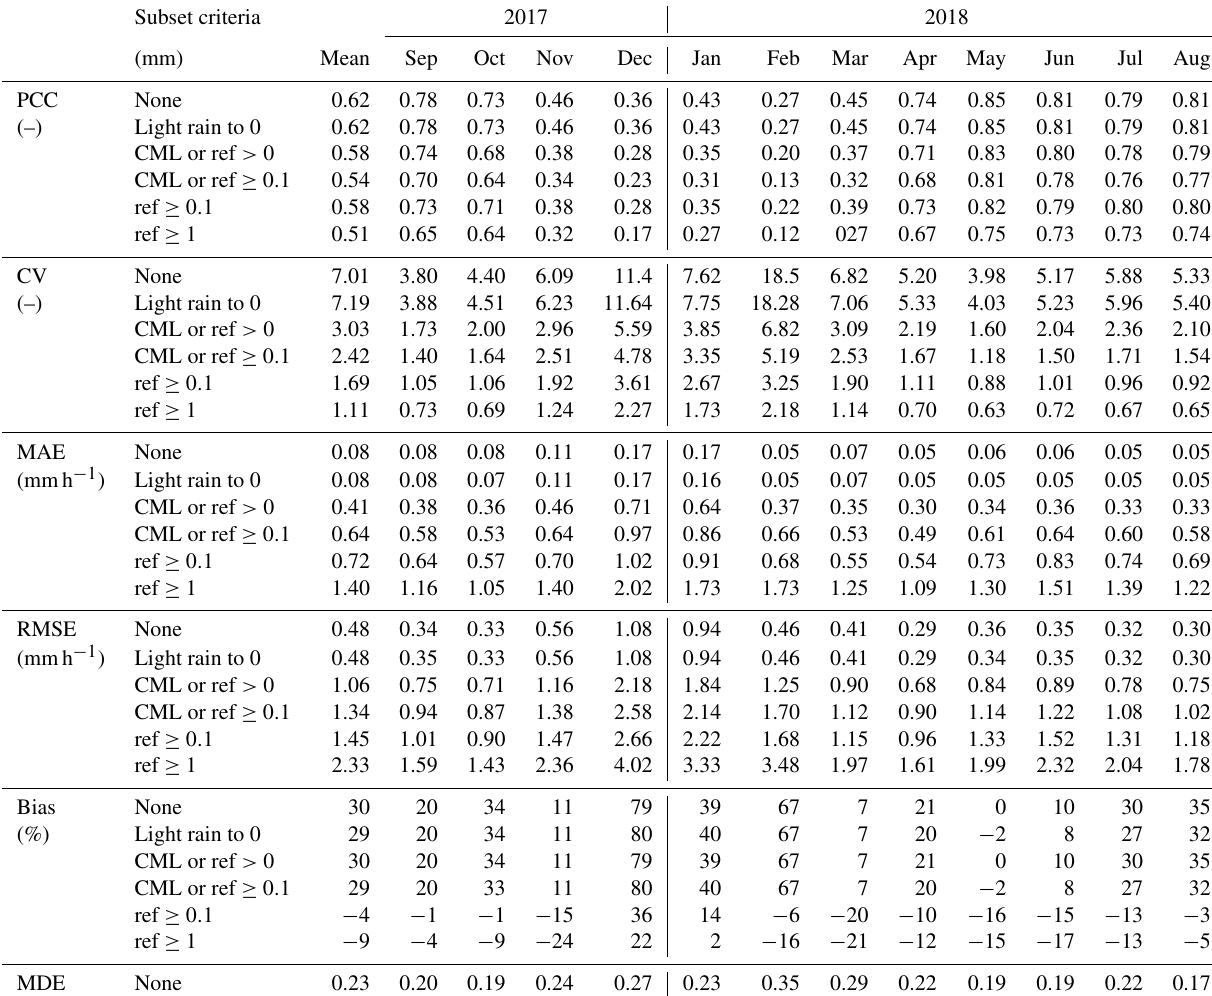
Table 2. Monthly performance measures between path-averaged, hourly CML-derived rainfall ( R CML ) and RADOLAN-RW as a reference ( R reference , shortened here to “ref”) for subset criteria and